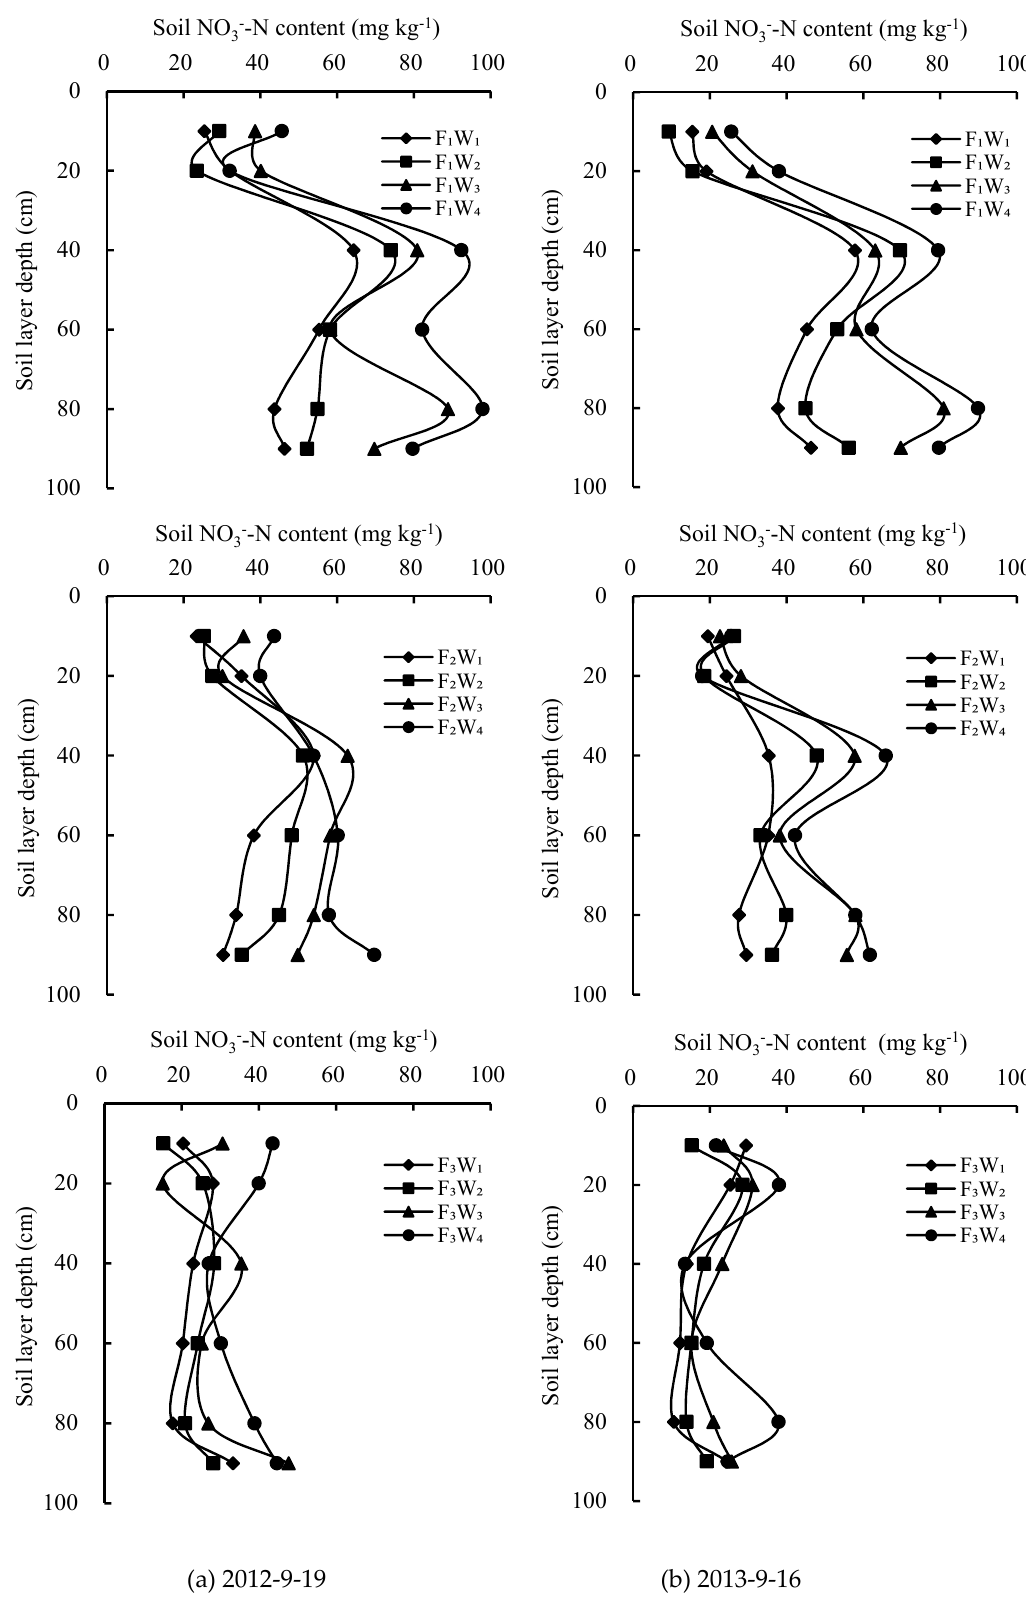
Figure 5. Effects of different water and fertilizer treatments on soil NO3 ‐ ‐ N content (0~90 cm) of young Figure 5. E ff ects of di ff erent water and fertilizer treatments on soil NO 3 − -N content (0~90 cm) of young apple trees on September 19th in 2012 (a) and September 16th in 2013 (b). apple trees on 19 September in 2012 ( a ) and 16 September in 2013 ( b